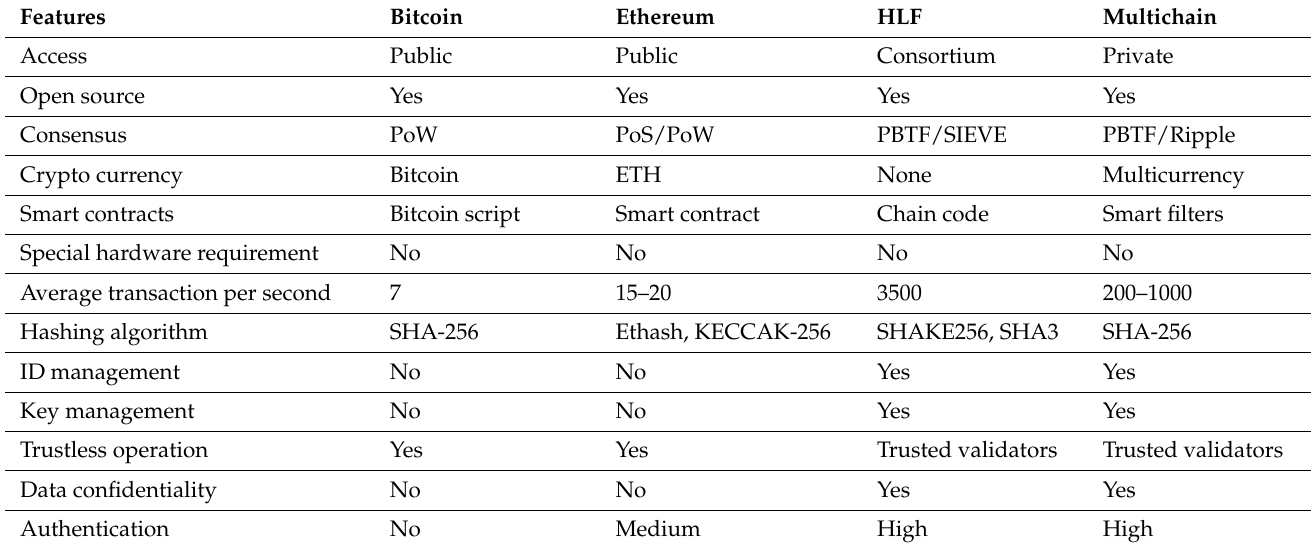
Table 2. Comparison of Bitcoin, Ethereum, HLF, and Multichain BCs’